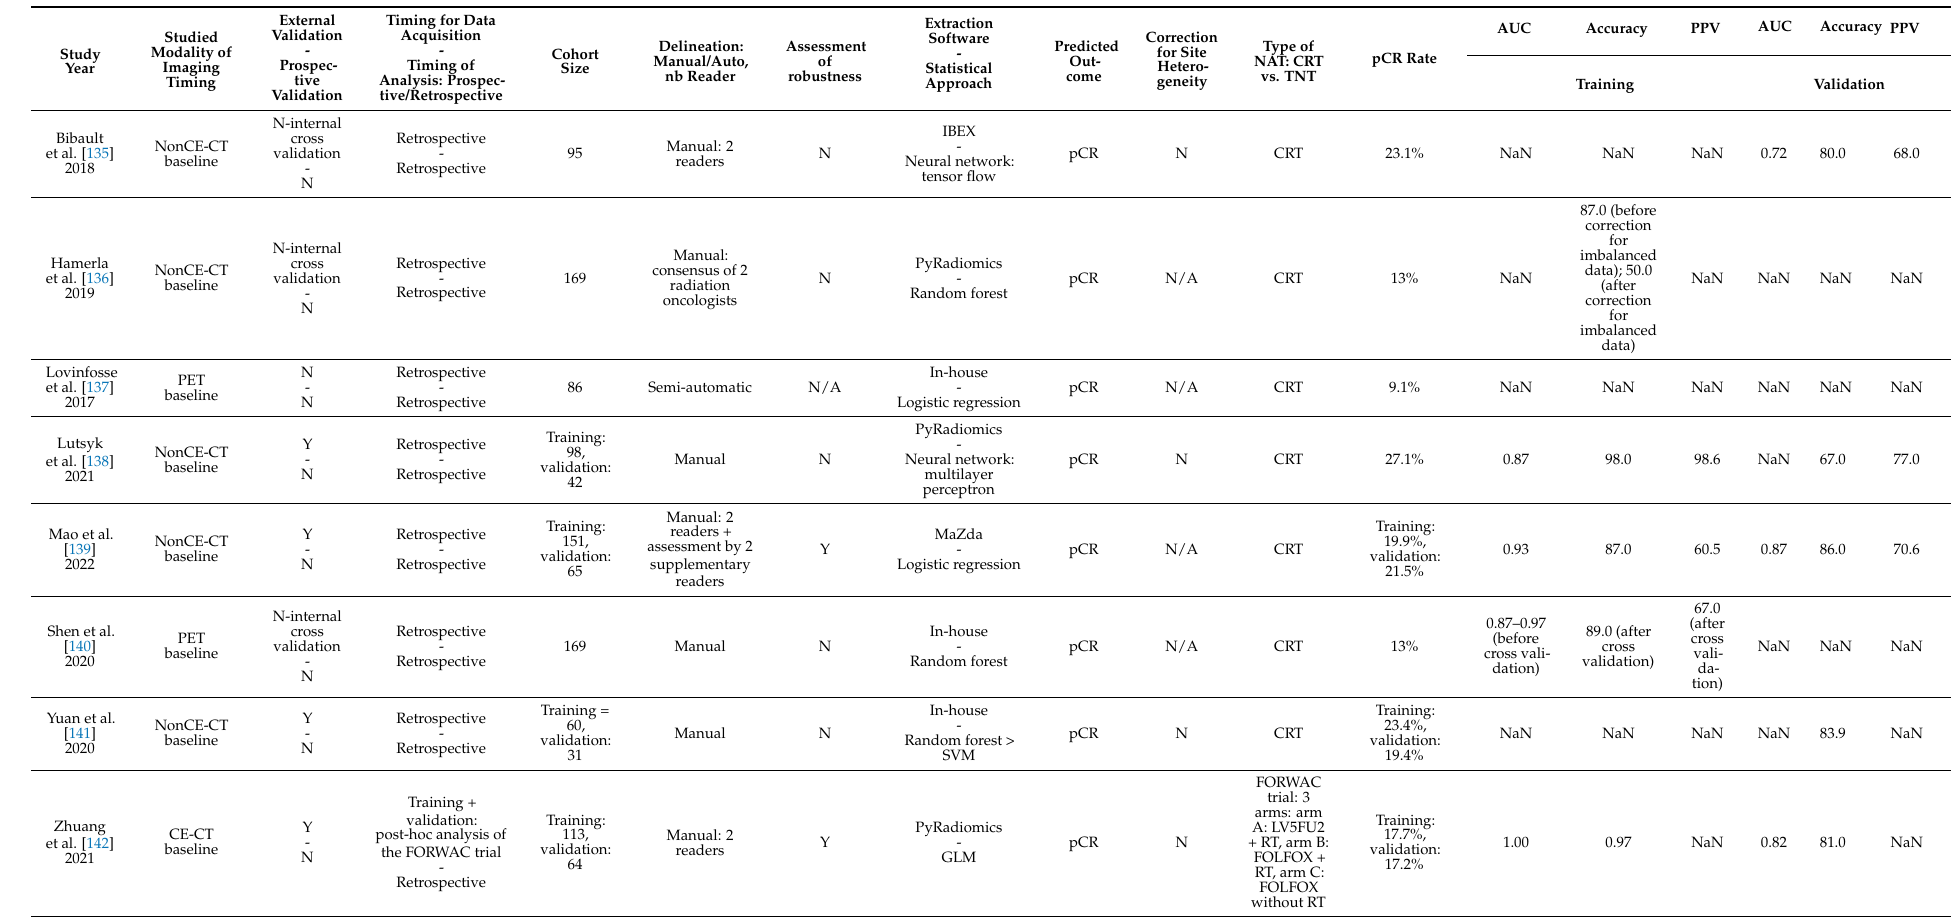
Table 3. Summary of non-MRI-based radiomics prediction